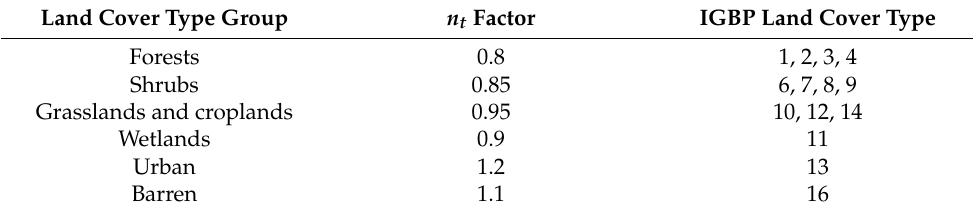
Table 1. List of n t factors related to land cover type group.